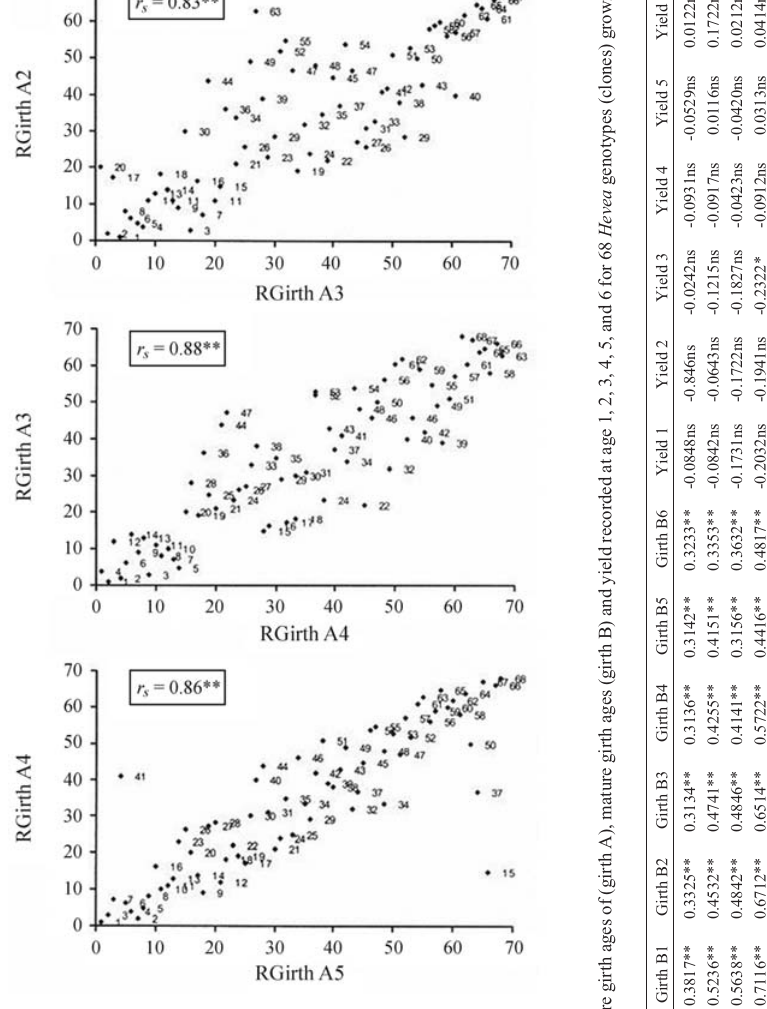
Figure 2 - Scatter plot of ranks for Girth A recorded between (i) age 2 and 3,(ii)age3,(ii)age3and4( iii )age4and5.Thecloneidentificationnum- bers are printed above the corresponding points in the